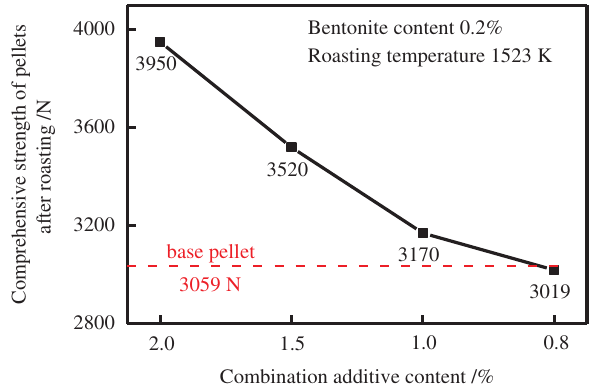
Figure 6: Effects of combination additive on comprehensive strength of pellets after roasting.